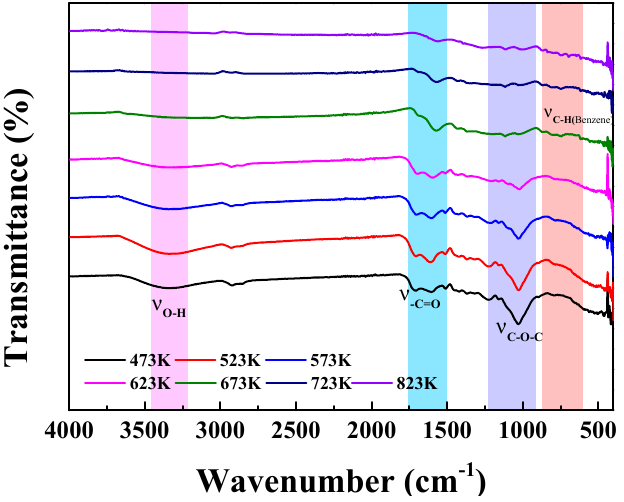
Figure 4. FT − IR spectra of BCs prepared using different pyrolysis temperatures. The elemental compositions and surface groups of CPP2000 were characterized by XPS (Figure 5). Obviously, CPP200 mainly contains C (51.57 wt.%), O (45.67 wt.%) and a small amount of S (0.12 wt.%) (Figure 5A), a finding that is consistent with the results of elemental analysis (Table 1). XPS-peak-differentiation-imitating analyses of C1s and O1s were also simulated. As shown in Figure 5B,C, the peak for the C1s can be deconvoluted into three components at 284.8 eV, 286.4 eV and 287.6 eV, which may be attributed to sp 3 C–C (58.40%), C–O (24.89%) and C=O (16.72%) bonds, respectively [30]. The deconvolution of the peak for the O1s confirmed the existence of C=O (28.91%), C-O (39.57%) and -OH (31.52%) species at binding energies of 533. 6 eV, 532.7 eV and 531.9 eV, respectively [38]. The XPS results again indicate that there are a considerable number of oxygen-containing functional groups on the surface of CPP200.